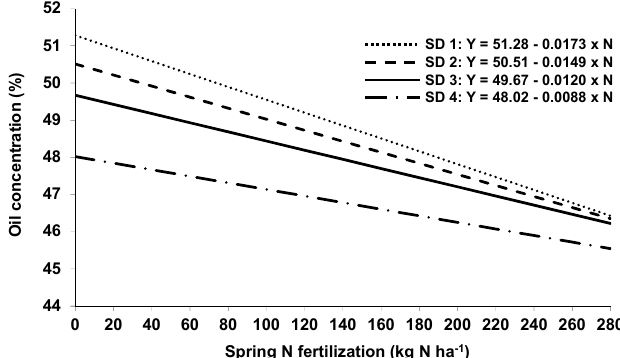
Figure 3. Effect of sowing method (SD) by spring N fertilization interaction on seed oil concentration